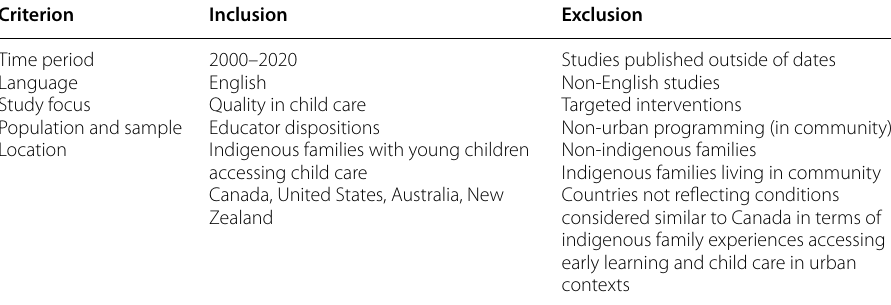
Table 2 Inclusion and exclusion criteria